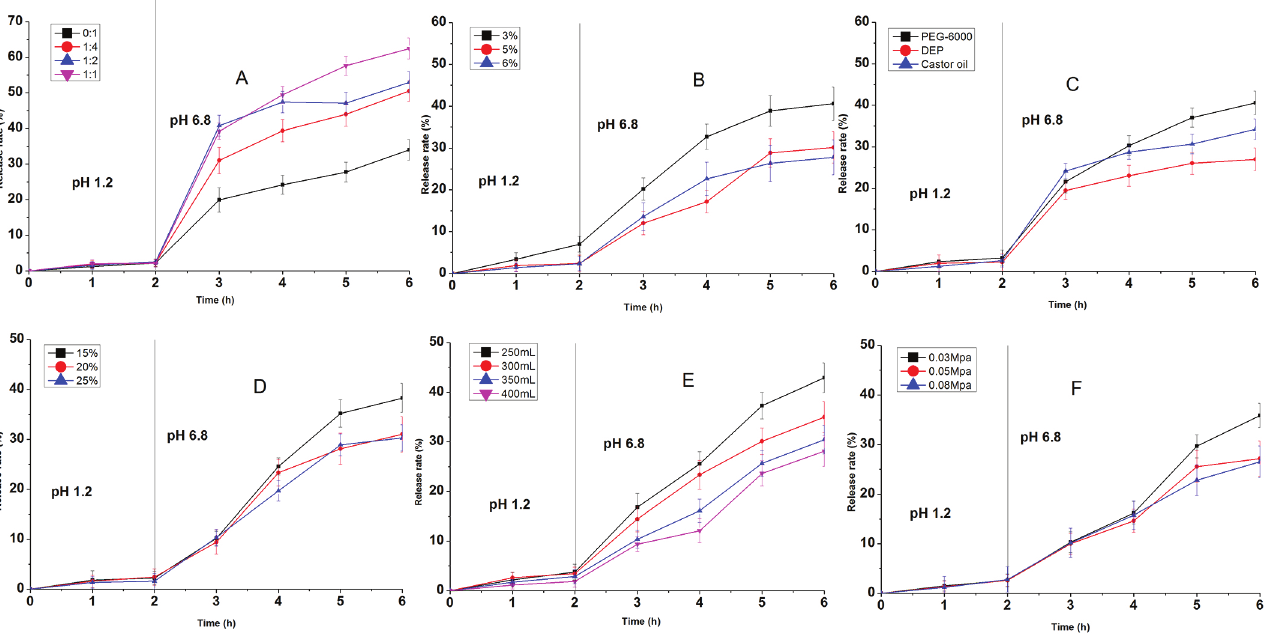
FIGURE 4 - The effect on dissolution rate in a simulated gastric fluid (pH 1.2) and a simulated small-intestinal fluid (pH 6.8) of the ratio of Eudragit S100 and L100 (A), the Eudragit S100 concentration (B), the type of plasticizers (C), the concentration of plasticizers (D), the amount of coating fluid (E) atomizing press (F).